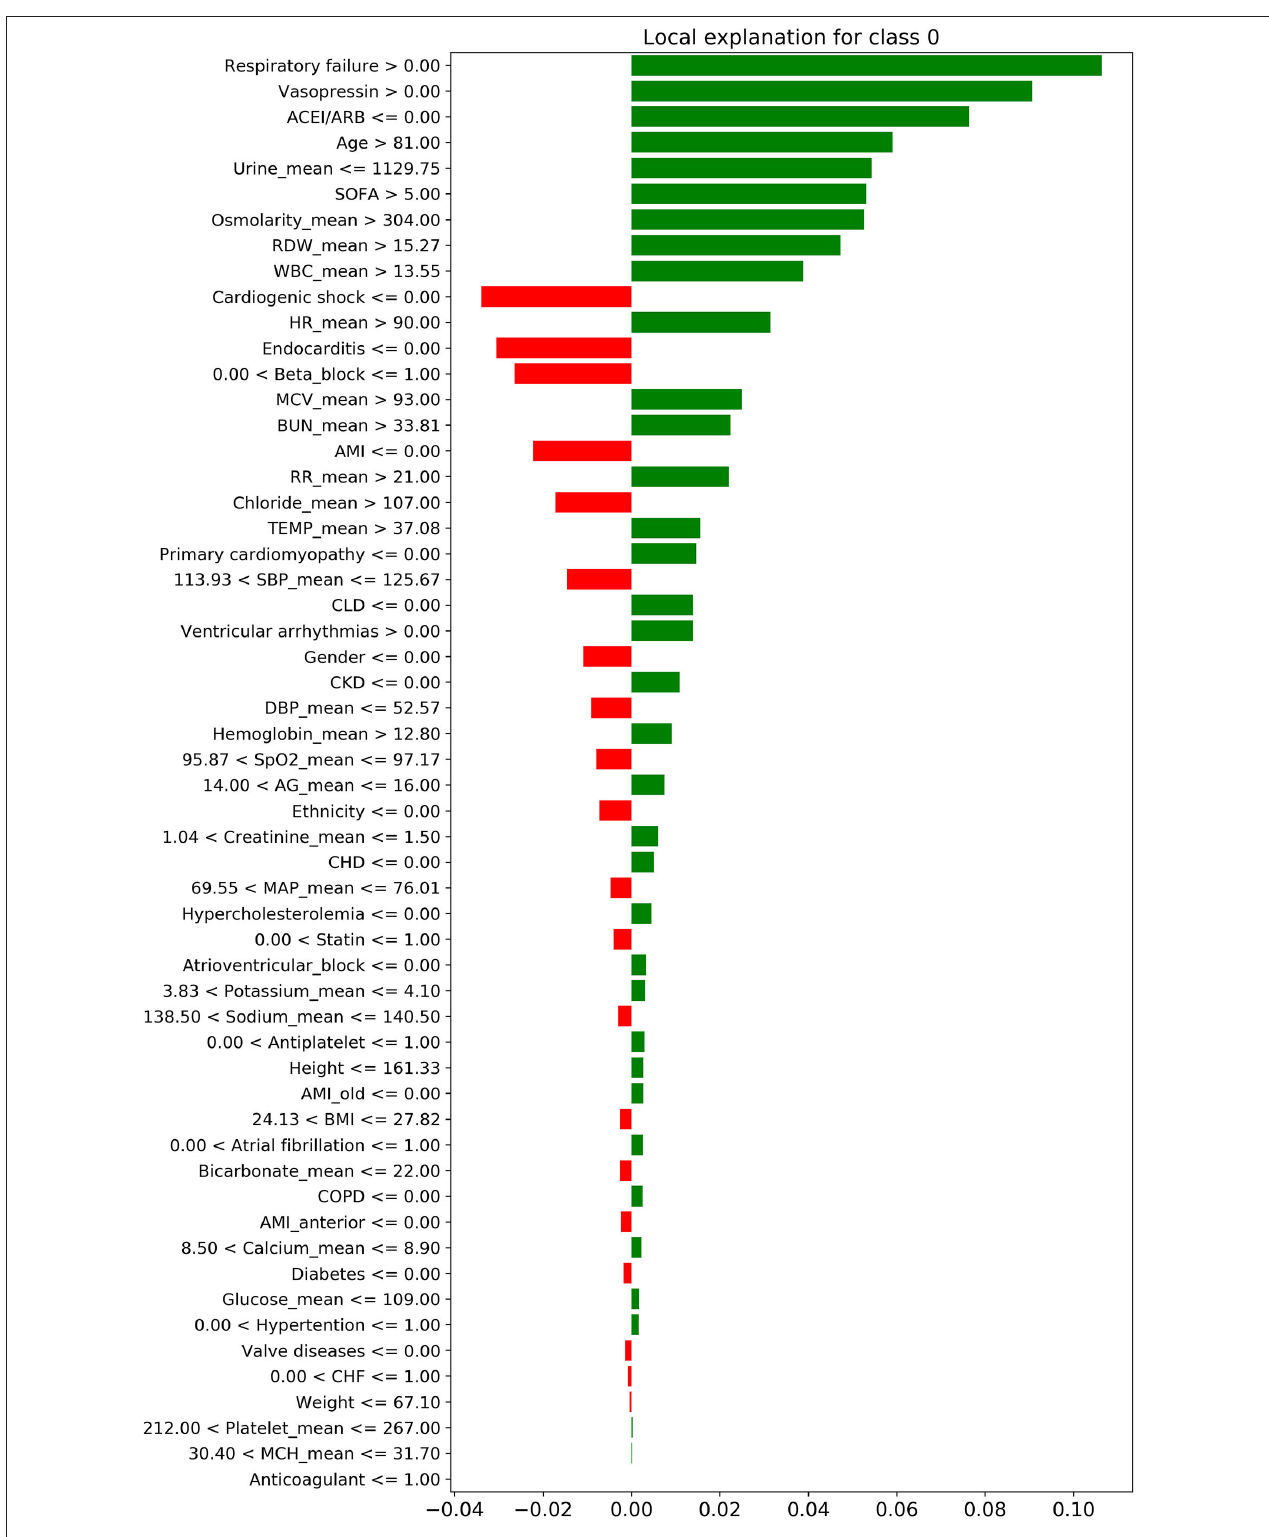
FIGURE 4 | The local interpretation of the XGBoost model for class 0. The features of the green column make the model identify the sample as class 0, while the features of the red column allow the model to identify the sample as non-class 0. Since the sum of green column score exceeded red, the model finally identifies this sample as class